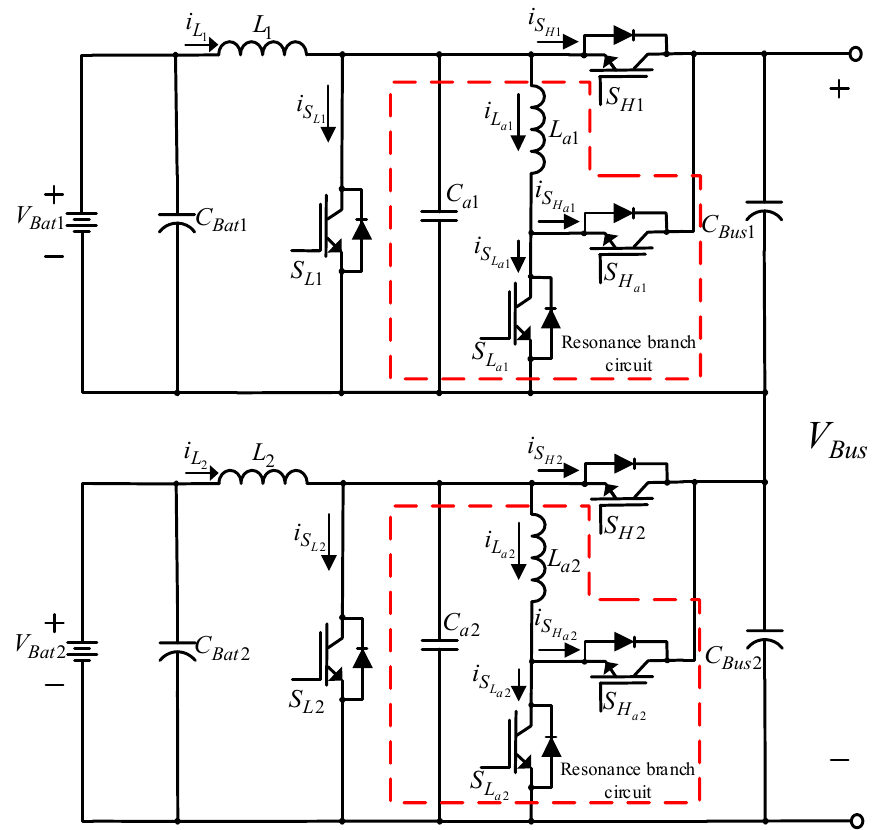
Figure 3. The adopted equalizing charge/discharge circuit architecture [1]. Table 1. The electrical specifications of the bidirectional buck–boost soft-switching converter .